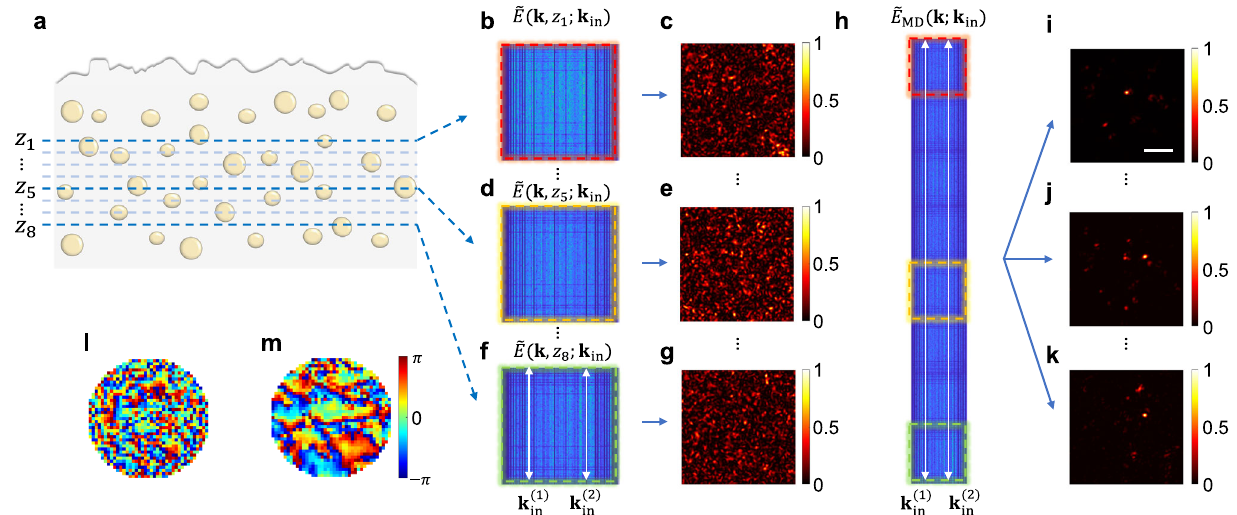
(cid:1) (cid:3) (cid:1) (cid:3) e E , constructed by appending e E cg k , z ; k in of eight adjacent MD k;k in